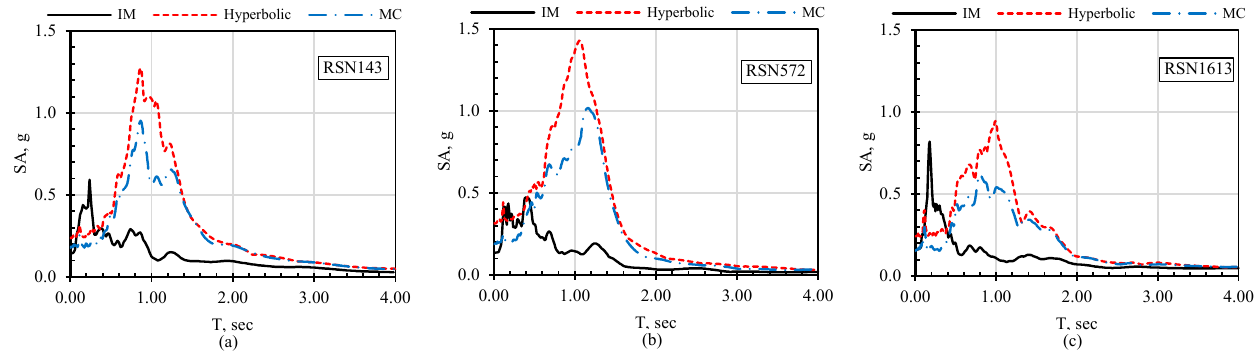
Figure 13. ARS of the superstructure (D = 5%) using Hyperbolic and MC models ( a ) RSN143, ( b ) RSN572, ( c ) RSN1613.